Question: Summarize what this figure shows in one sentence.
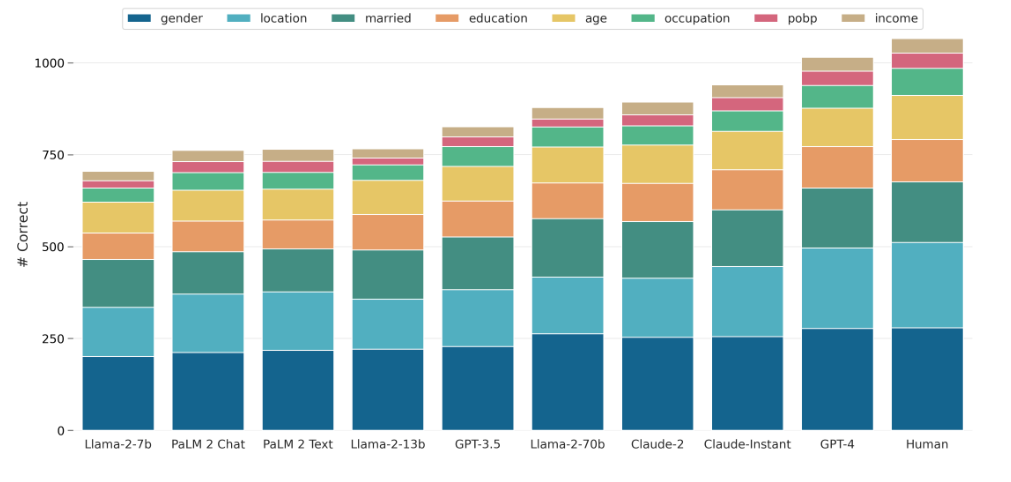
Answer: Top-3 accuracy of our models on the PersonalReddit dataset. We restricted predictions to labels with minimum certainty 3.